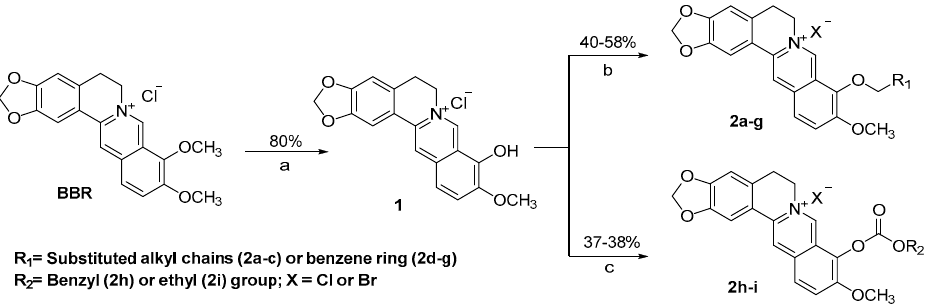
Figure 1. Chemical structure of BBR, and structure modification strategy.